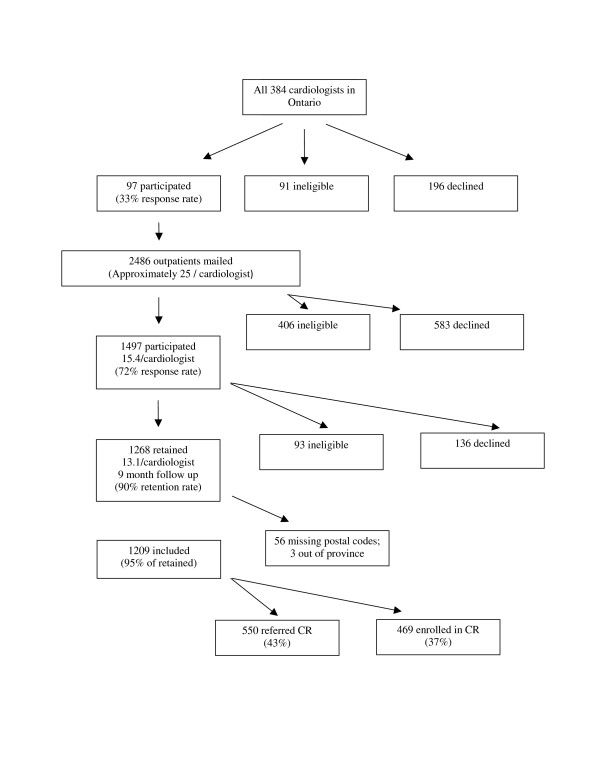
Participant Recruitment and CR Participation.